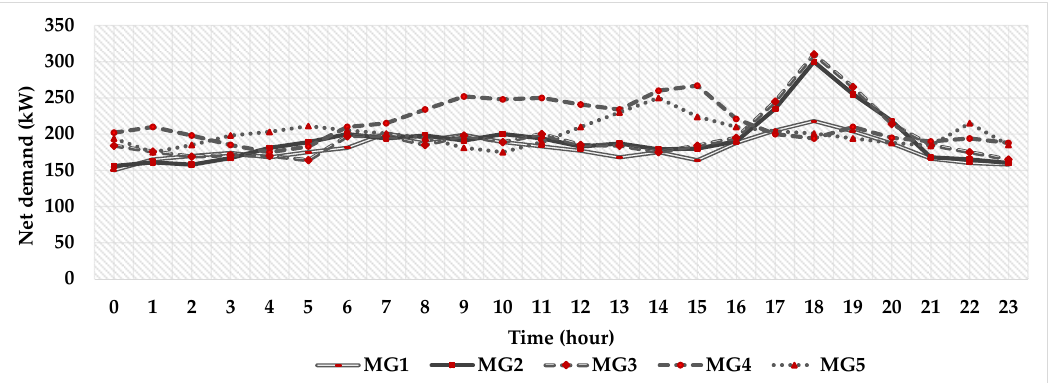
Figure 4. Net demands of the microgrids (MGs). Table 2. Simulation conditions.